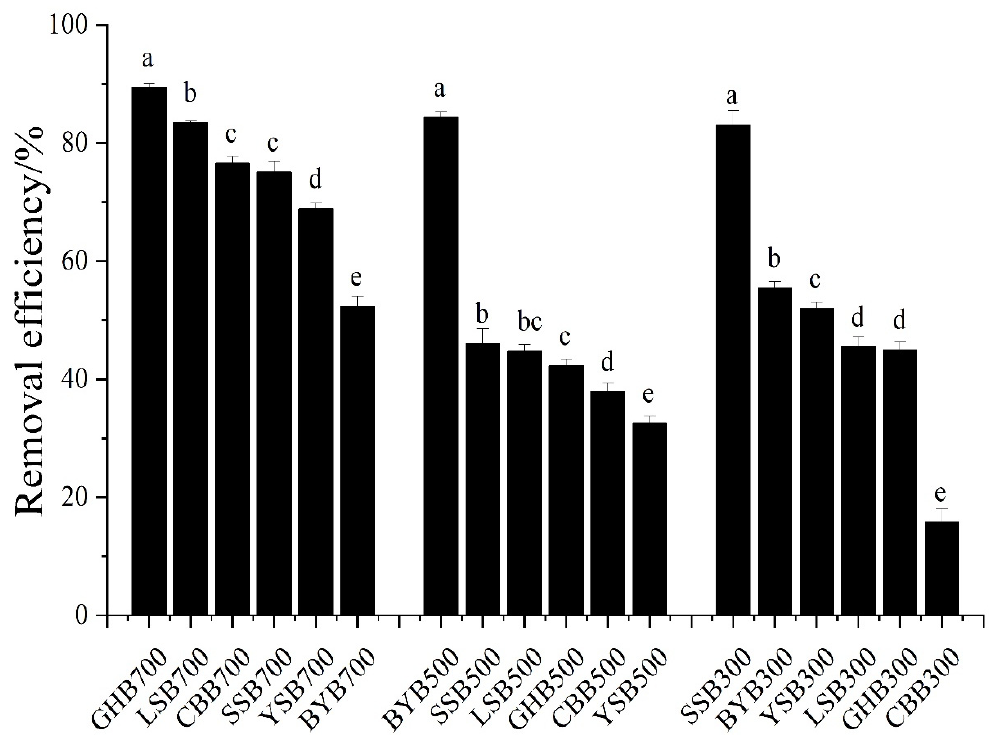
Figure 3. Comparison of biochar removal efficiencies under the same preparation conditions (initial Cr (VI) concentration: 50 mg·L − 1 ; dosage of biochar: 1.2 g·L − 1 ; pH: 2), different letters show significant differences at α = 0.05.